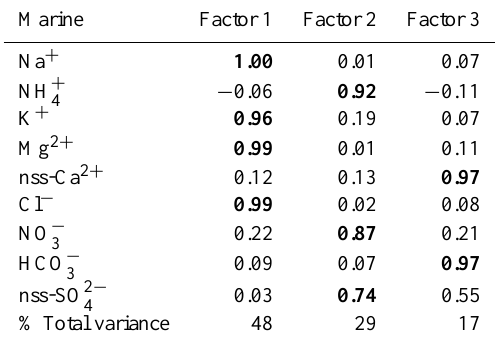
Table 3. Factor loadings and total variance identified in the Marine trajectory group. ∗ Bold font indicates that the factor loading is significant at 95%